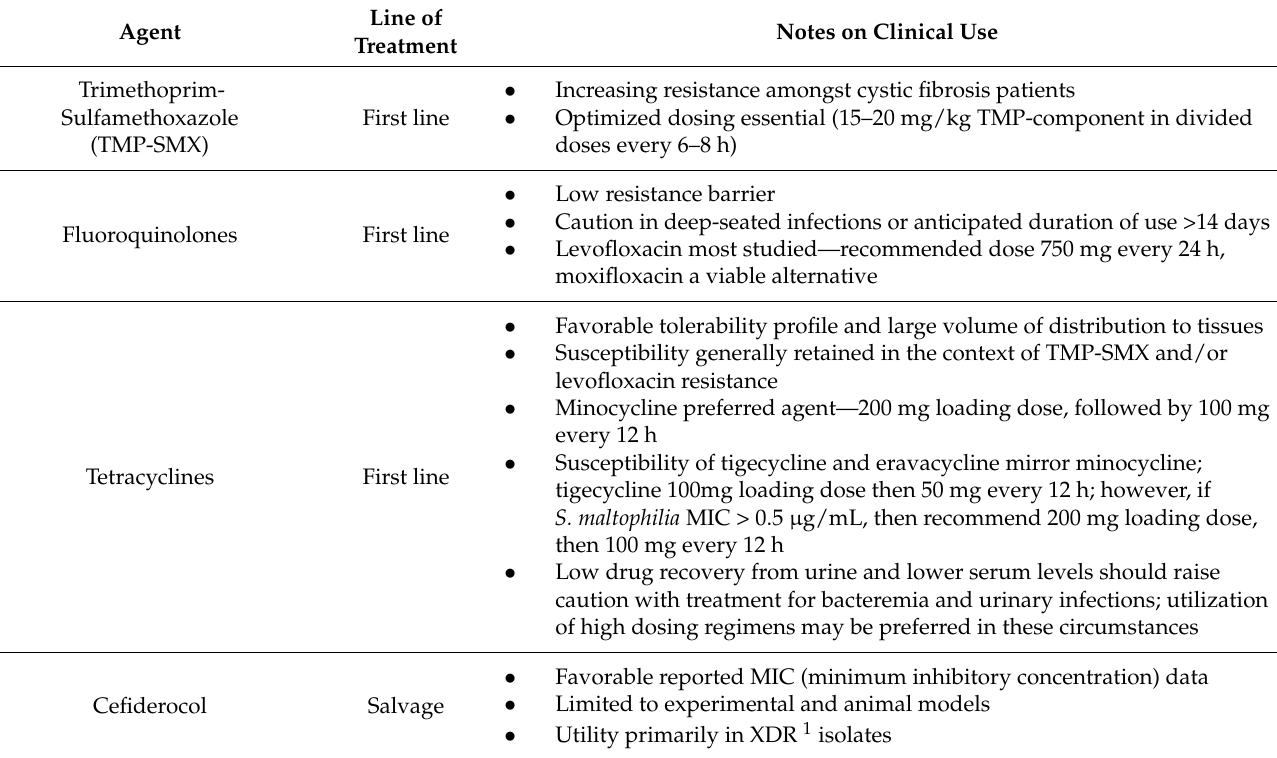
Table 1. Recommended treatment approach for Stenotrophomonas